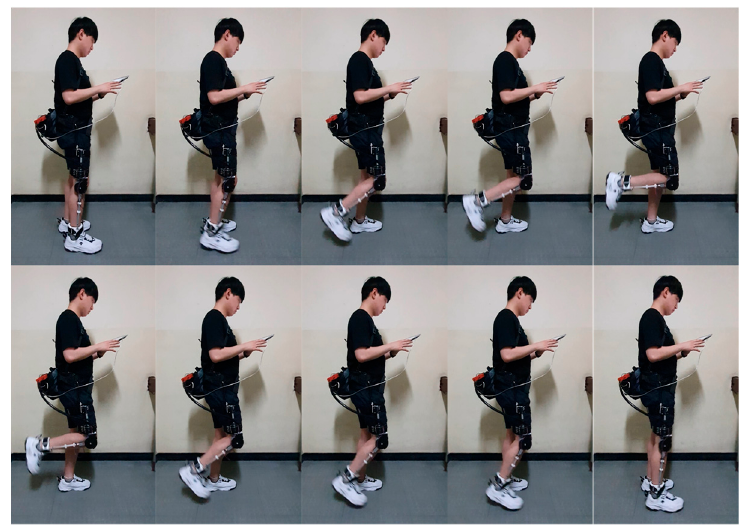
Figure 10. Friction compensation experiment snapshot. Starting from the standing position, the knee moved repeatedly to perform the friction compensation test.